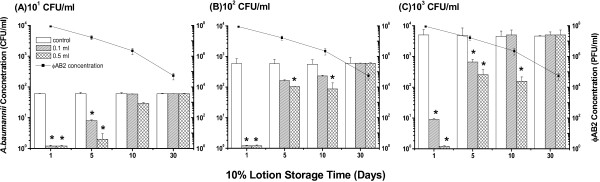
Bactericidal effect of 0.1 ml and 0.5 ml of ϕAB2-containing lotion (stored up to 30 days) on different concentrations: (A) 101 (B) 102, and (C) 103 CFU/ml of A. baumannii M3237 contaminated agar. Phage titers (■) are shown on the right on the logarithmic scale. *p < 0.05 compared with the respective control group.